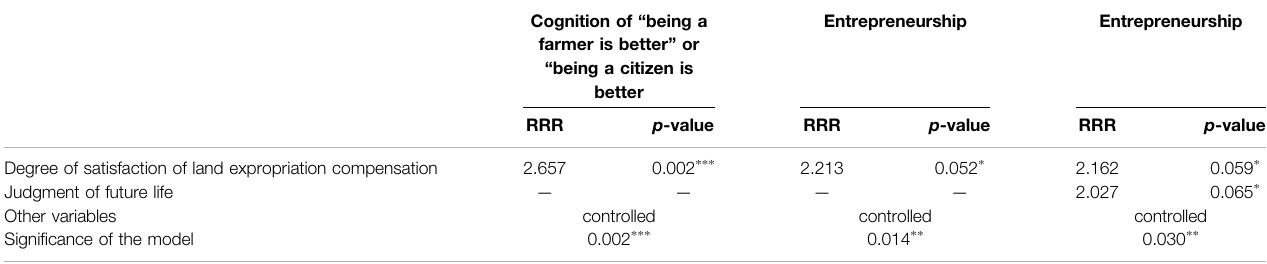
TABLE 6 | Regression analysis of the mediating effect of the degree of satisfaction of land expropriation compensation on the judgment of future